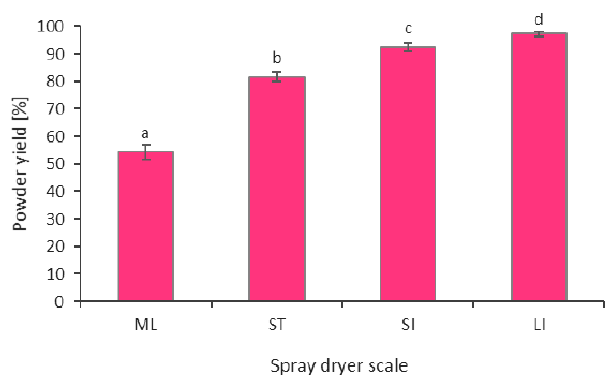
Figure 1. Powder yield of spray dried beetroot juice at different process scales (ML—mini-laboratory scale, ST—semi-technical scale, SI—small industrial scale, LI—large industrial scale; a, b, c, d— different letters show significant differences between spray dryer scale ( p ≤ 0.05)).